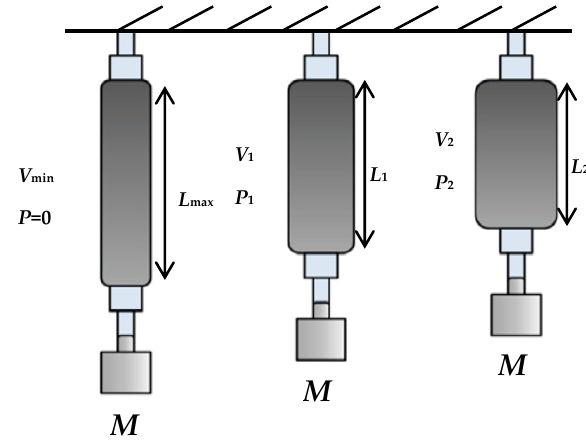
Figure 3. Isotonic characteristic of the pneumatic muscle actuator.